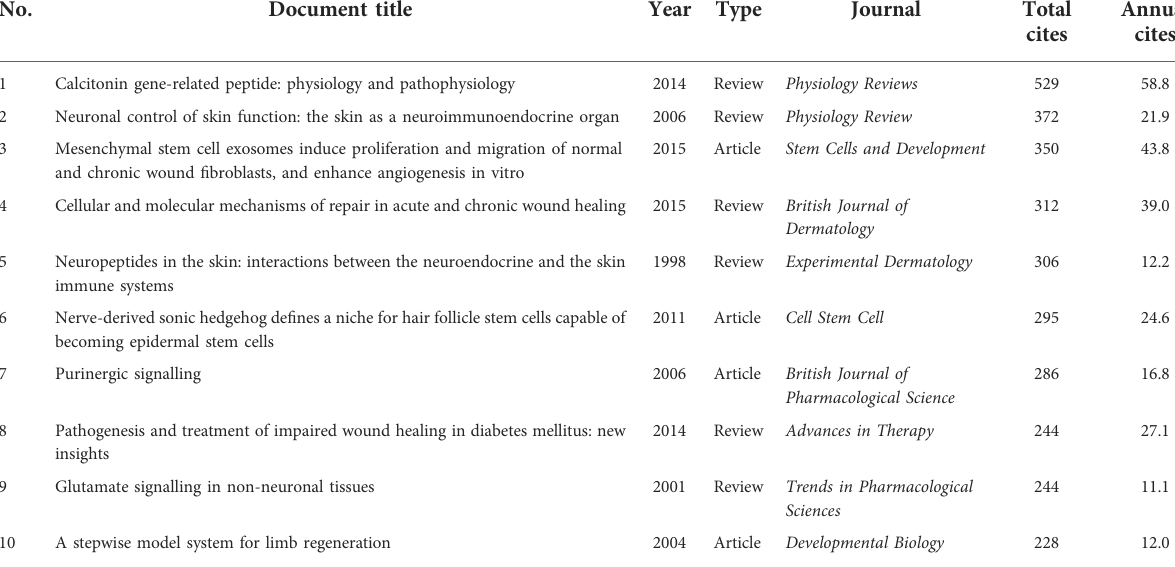
TABLE 3 Top 10 most frequently cited documents on the effects of skin innervation on wound healing.